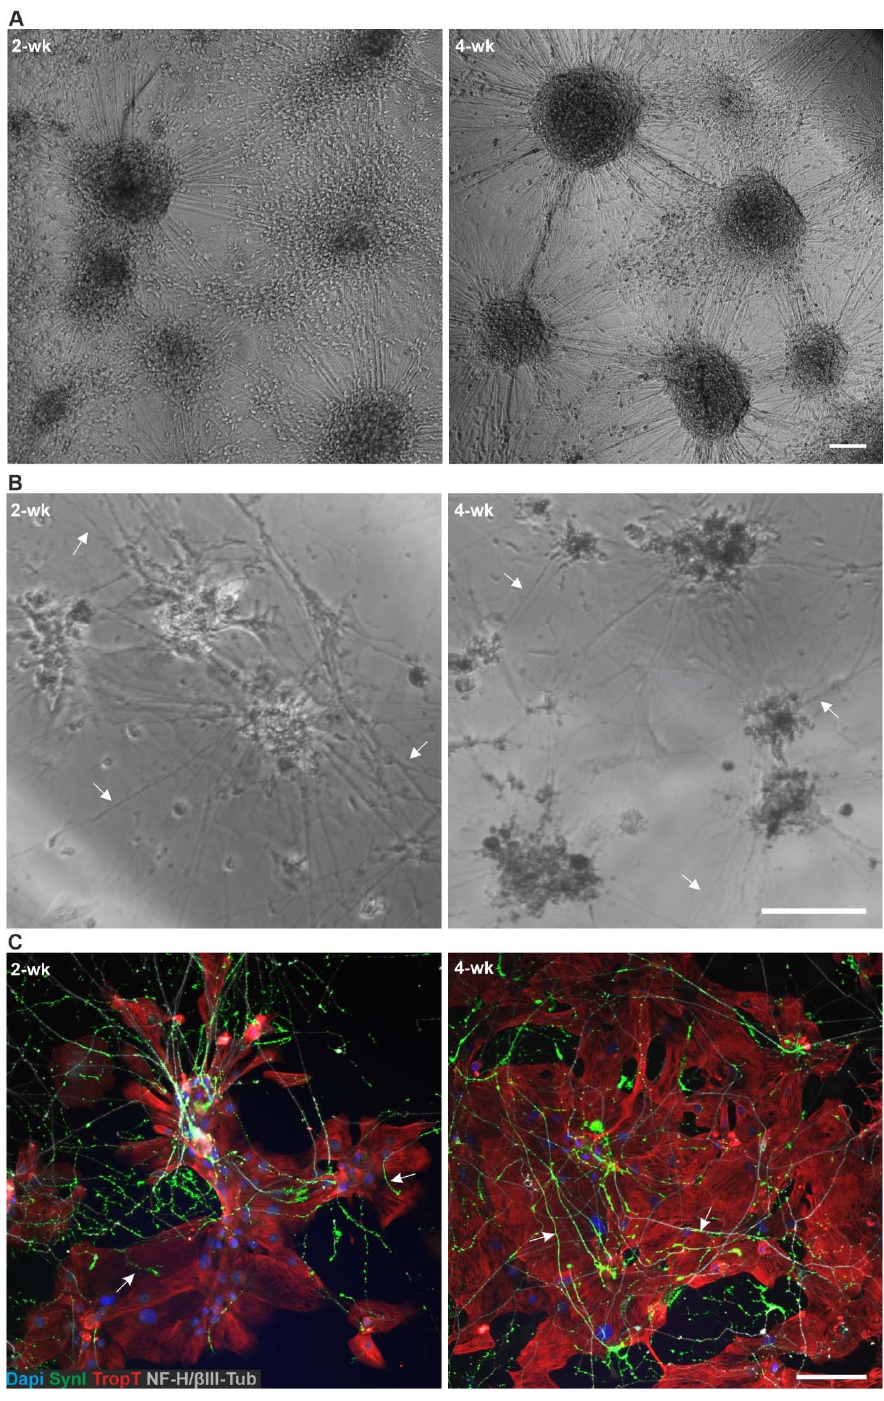
Figure 1. hiPSC ‐ derived neurons and CMs in the 3D3C chip at 2 ‐ and 4 ‐ week timepoints of coculture. ( A ) A phase ‐ contrast image showed viable neuronal somas isolated in their compartment and forming axonal networks. ( B ) Neuronal axons (white arrows) traversed to the middle compartment via microtunnels and CMs were viable among the axons. ( C ) ICC staining showed that neuronal axons stained against monoclonal anti ‐ neurofilament NF ‐ H 200 and monoclonal anti ‐ β‐ tubulin III (NF ‐ H/ β III ‐ Tub, white) interacted with CMs stained against cardiac marker Troponin T (TropT, red) in the middle compartment. Evidence of synaptic interactions between CMs (TropT, red) and neurons (Synapsin I (SynI), green) can also be observed (white arrows). The scale bar is 100 μ m, and blue indicates a nuclear marker (DAPI).